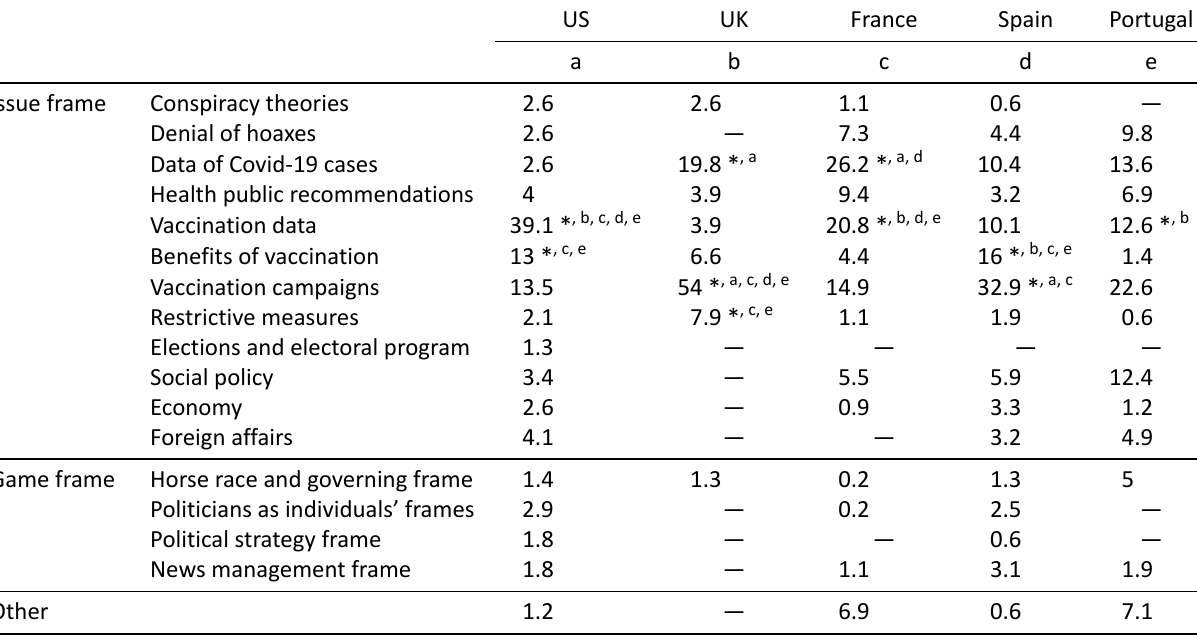
Table 3. Issues and strategies in the tweets of the health experts by country (%).